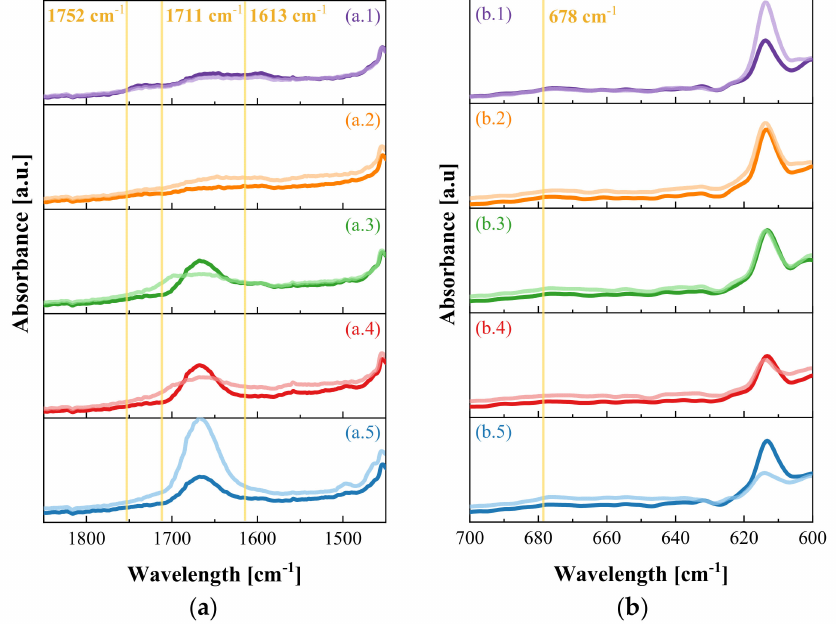
Figure 4. FTIR-ATR in the ranges ( a ) 1450-1850 and ( b ) 600-700 cm − 1 of samples (1) P-1, (2) PZ-1, (3) PVZ-1, (4) PVZ-4, and (5) PAZ-1, before (darker line) and after (lighter line) n -decane photocat- alytic oxidation.